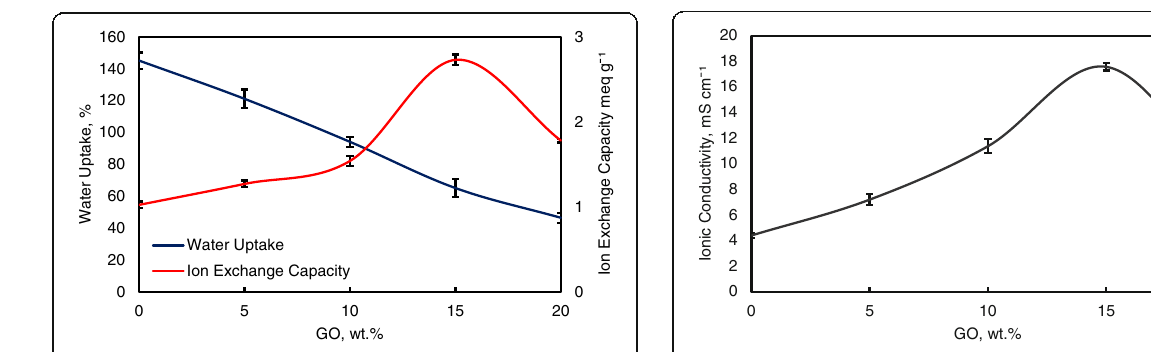
Fig. 8 Water uptake and IEC analysis of QPVA membrane and QPVA/GO composite membrane at 30 °C